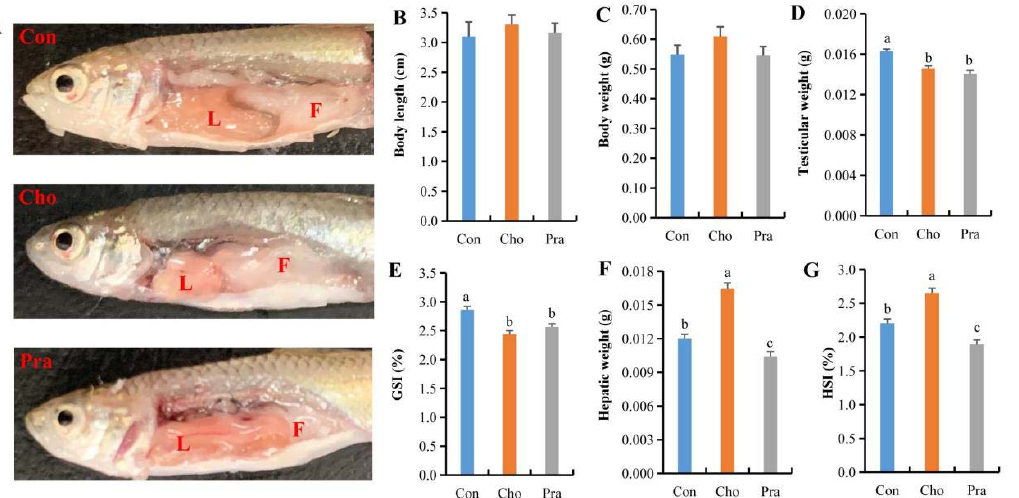
Figure 1. Changes in intraperitoneal lipid deposition and biological indicators of G. rarus ; ( A ) changes in abdominal fat deposition, L: liver, F: fat; ( B ) body length; ( C ) body weight; ( D ) testicular weight; ( E ) GSI; ( F ) hepatic weight; ( G ) HSI; All statistical data were expressed as mean ± SD. There is a significant difference between the two groups without the same letter at p < 0.05 level.